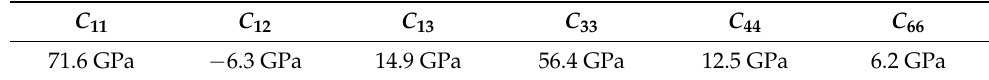
Table 2. Stiffness constant value